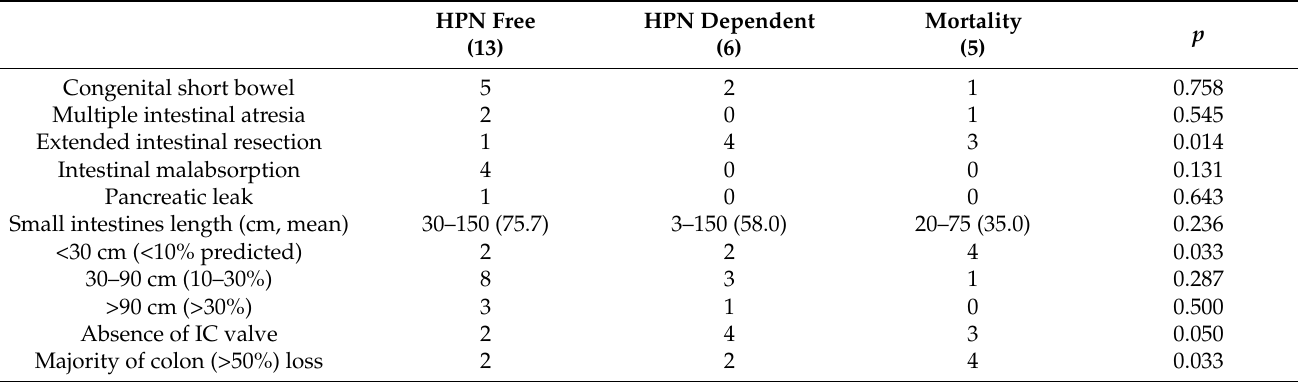
Table 3. Major causes and related anatomies of SBS or IF of pediatric HPN